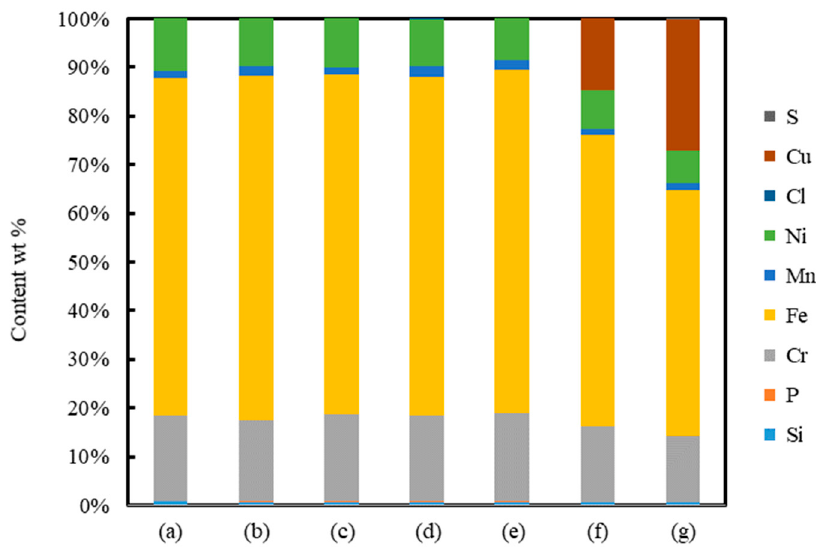
Figure 12. Relationship between elements of surfaces of ( a ) non-irradiated area and irradiated areas with N = 500 pulses at F = 0.04 J/cm 2 under ( b ) air, ( c ) water, ( d ) 5 wt% NaCl solution, ( e ) 5 wt% NaNO 3 solution, ( f ) 5 wt% Cu(NO 3 ) 2 solution and ( g ) 5 wt% CuSO 4 solution.